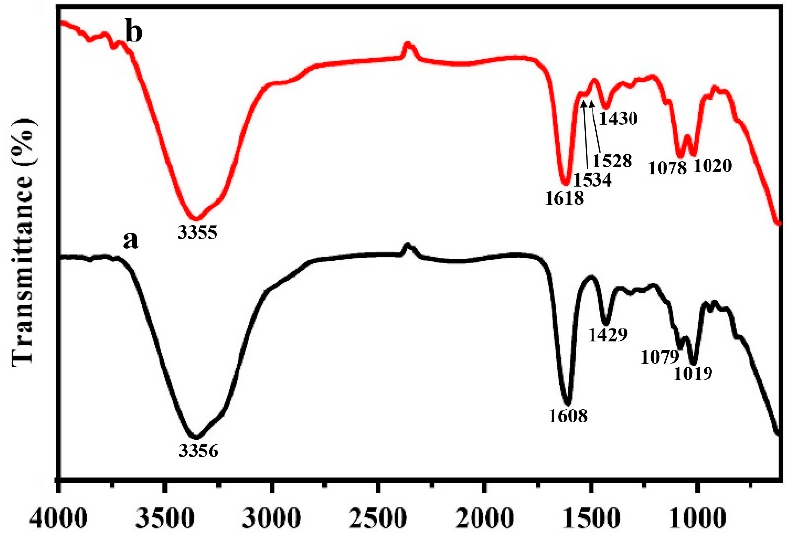
Figure 5. Fourier transform infrared spectra of BSA/ALG MPs ( a ) and BSA/ALG/CHI MPs ( b ).